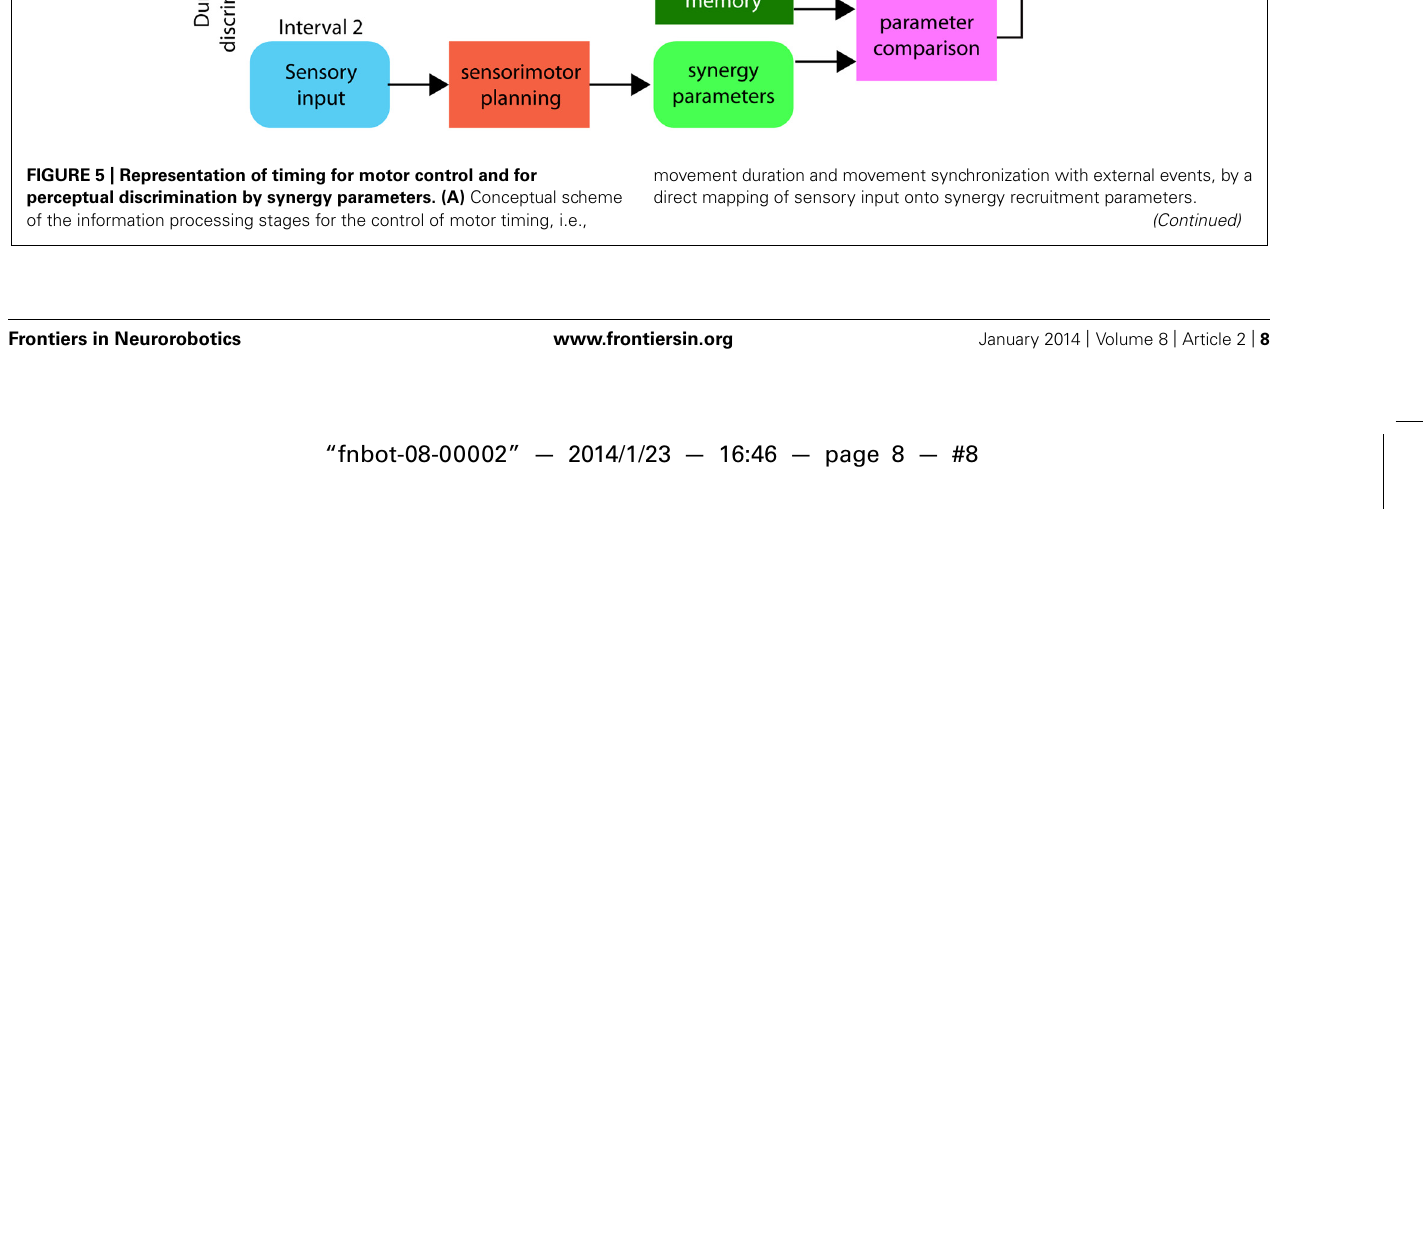
movement duration and movement synchronization with external events, by a direct mapping of sensory input onto synergy recruitment